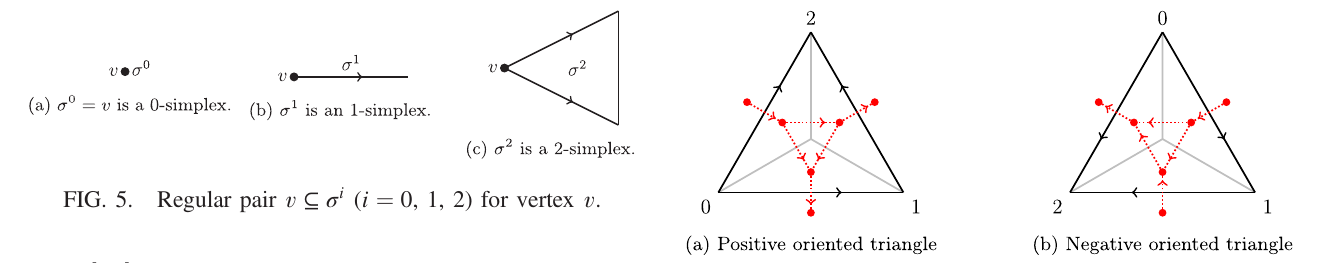
˜ T FIG. 6. Triangulation T (black line), resolved triangulation ˜ P (black and gray line), and resolved dual lattice (dashed red ˜ T line). The resolved triangulation was obtained from the original T by adding a new vertex to the center of each triangle. The links of P have orientations induced from the link orientations of T according to the conventions shown in Fig. 7(a). Red dots on the ˜ P vertices of represent Majorana fermions that split from the complex fermions on each link of T (see the discussion in Sec. III B). ˜ P The second step is adding directions to links in T and .